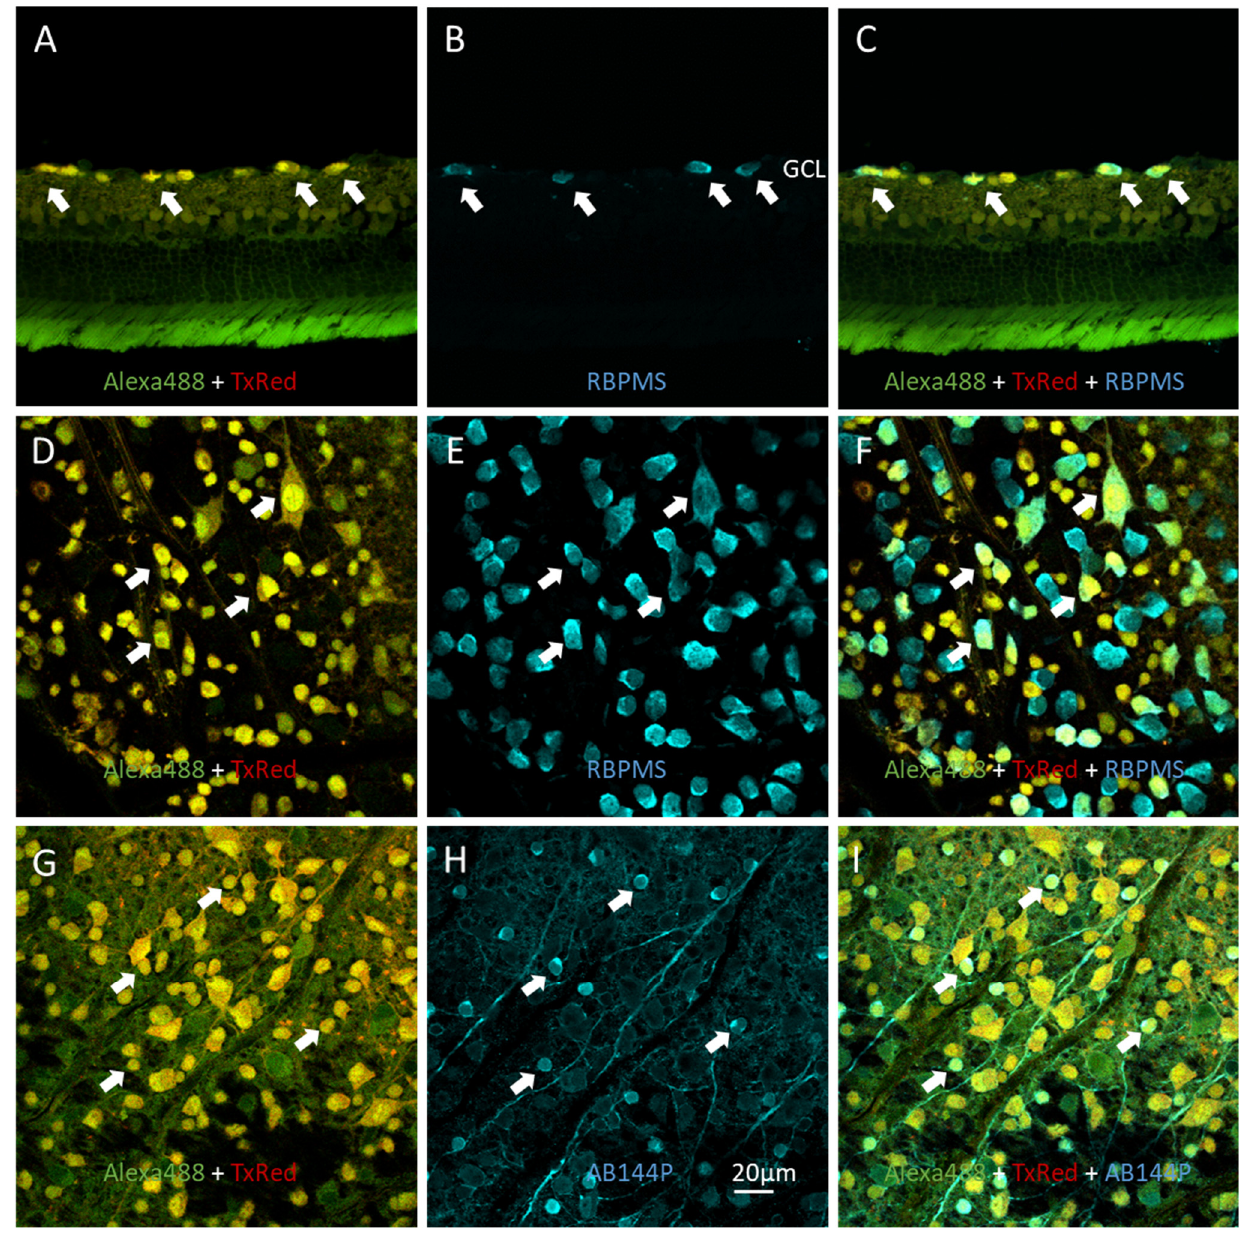
Figure 2. Immunohistochemistry staining on control healthy rat retinas confirmed uptake of intrav- itreal injected KcapTR488 in RGCs and displaced amacrine cells. Immunofluorescence staining in retina cross sections ( A – C ) and flat mount ( D – F ) retinas for RGC marker RBPMS ( B , C , E , F ) showed uptake of reporter KcapTR488 by RGCs. Immunohistochemistry staining of amacrine cell marker AB144P in flat mount retina ( G – I ) showed uptake of reporter KcapTR488 by displaced amacrine cells. Arrows indicate sets of RBPMS or AB144P-positive cells that had KcapTR488 uptake labeled as yellow in control retinas. Scale bar (20 µ m) in ( H ) applies to ( A – I ). Ganglion cell layer